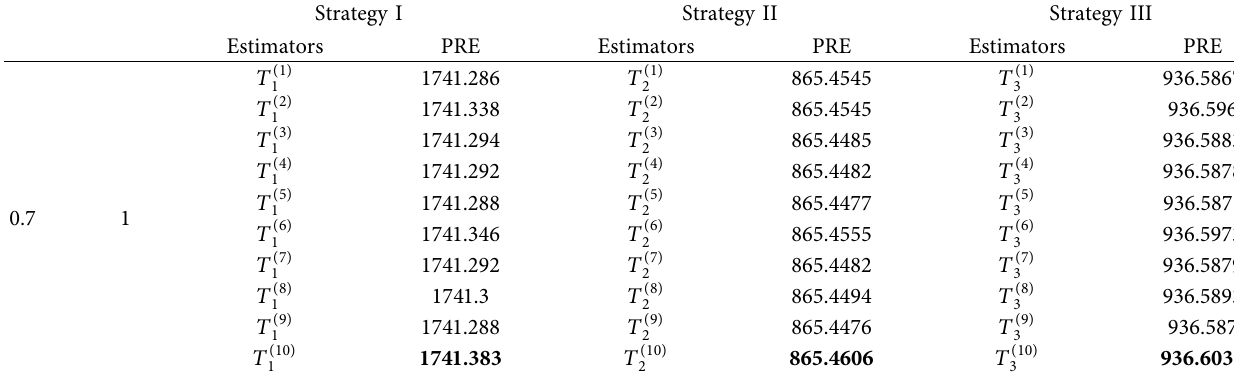
Table 12: PRE of the existing and proposed class of estimators of Population-IV at ρ ∗